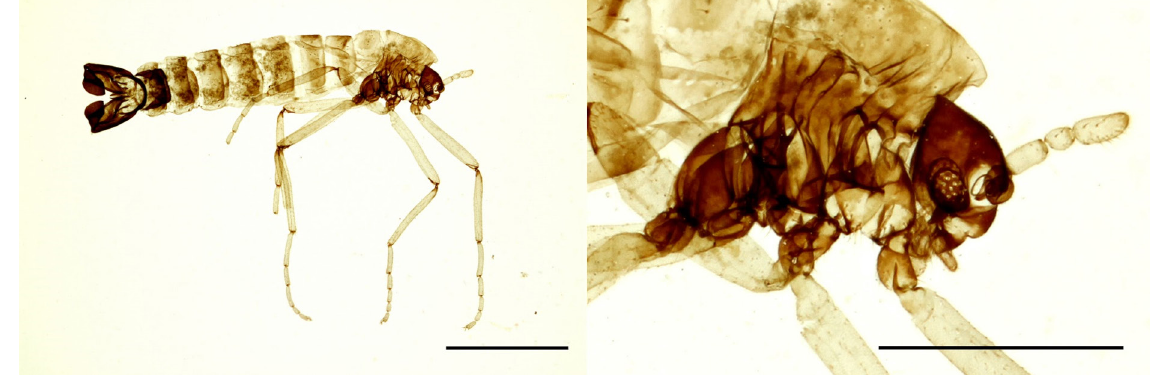
Fig. 2.8. Pictures of a microscope plate. Left: a microscope plate with an overview of a specimen of Belgica antarctica using a white background (scale = 1 mm). Right: a detailed view of the left image (scale = 500